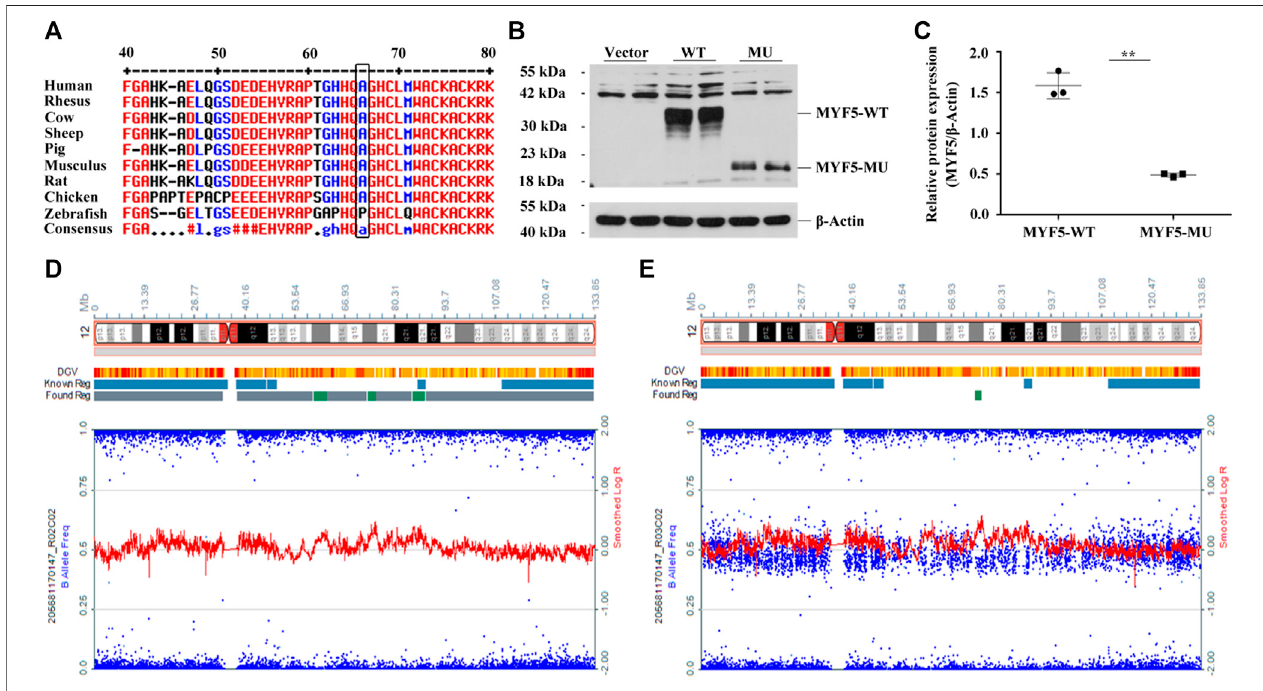
FIGURE 2 | Functional study of c.191delC and genome-wide SNP array results of the proband and the father. (A) p.Ala64 is highly conservative across different species. (B) , (C) Western blotting indicated the signi fi cant downregulation of MYF5 by 69.14% (** p < 0.01) in cells transfected with p3 × FLAG-CMV-10- MYF5 -MU comparedtothosetransfectedwithp3 × FLAG-CMV-10- MYF5 -WT,resultinginatruncatedproteinwithasizeof ∼ 20 kDa.Vector:p3 × FLAG-CMV-10. (D) , (E) Genome- wide SNP array results of the proband and the father, respectively (only chromosome 12